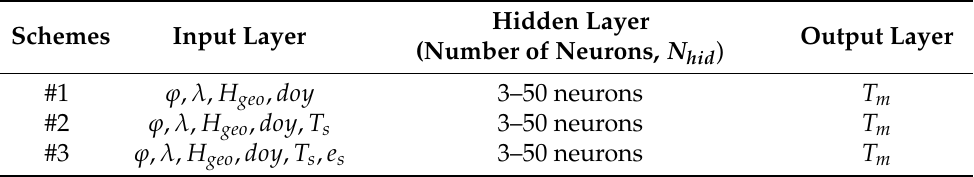
Table 2. Three modeling schemes with different neural network